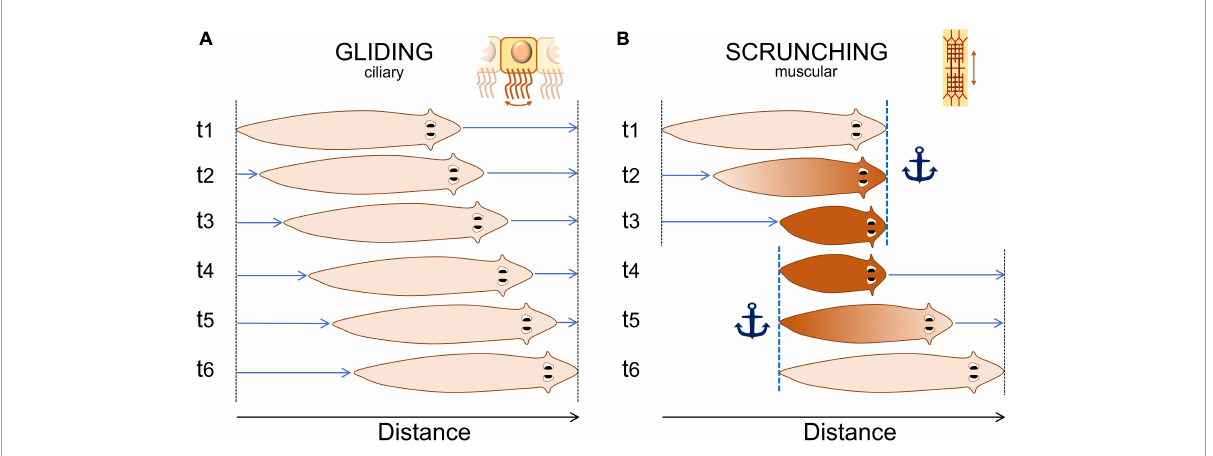
FIGURE2 Normal “gliding” and noxious “scrunching” behavior representation. (A) Typical gliding behavior of planarians. They produce mucus and glide at a constant rate on a surface using ciliated cells located on their ventral side. Gliding speed is usually about 1–5 mm/s. (B) Typical noxious “scrunching” behavior. Scrunching is a muscular gait. The head is first anchored to the surface (t1), the body contracts (t2), anchor is switched from the head to the tail (t3 to t4), then the body elongates forward (t5), and loops to the first step (t6). The frequency of one loop varies between 0.2 and 0.8 Hz depending mostly on the species (Cochet-Escartin et al., 2015). Scrunching sometimes happen in reverse order, making the worm scrunch backward for a few seconds